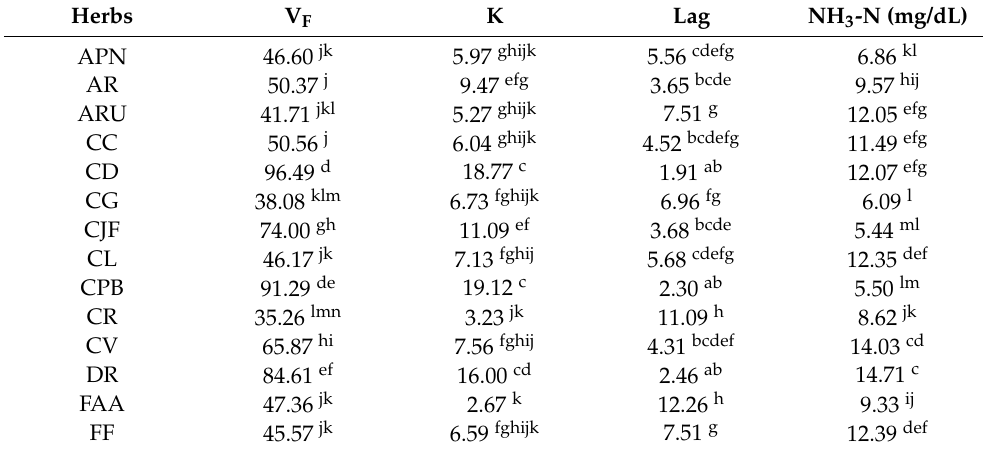
Table 6. Fermentation kinetic parameters and ammonia-N (NH 3 -N) concentration of 29 different Chinese herbs at 48 h of in vitro